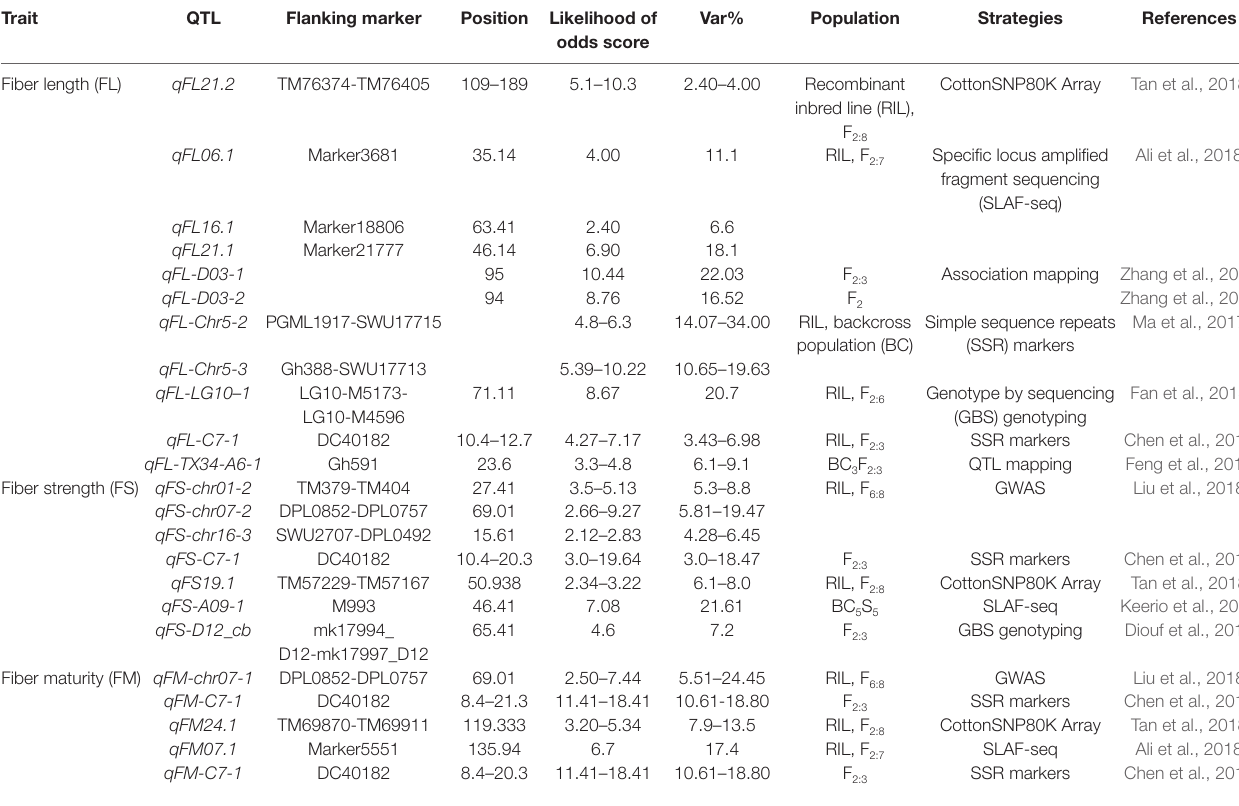
TABLe 2 | List of stable QTLs for fiber-related traits in different studies. Trait